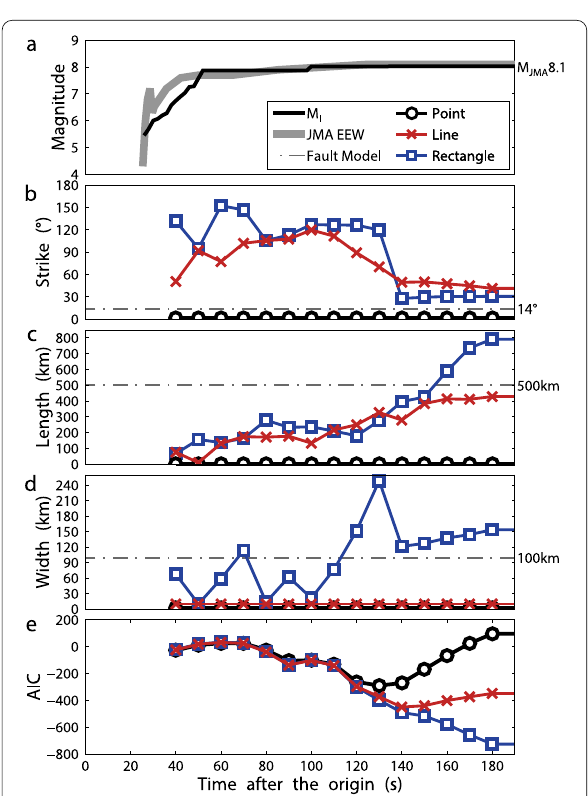
Fig. 5 Time history of the source parameters for the 2011 Tohoku earthquake. a Magnitude, b fault strike, c fault length, d fault width, and e AIC. In a , black and gray lines show the intensity magnitude and JMA EEW magnitude, respectively. b – e Black, red, and blue lines show the PS, LS, and RS models, respectively. The broken line shows the source model in Shao et al.